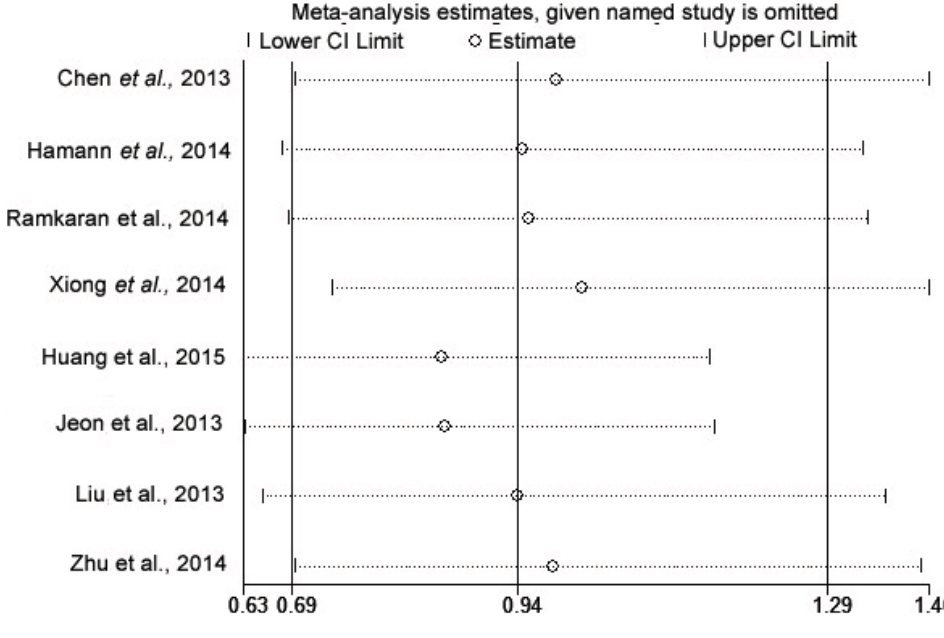
Figure 4. The influence of each study by removal of individual studies in China for G vs. C model.